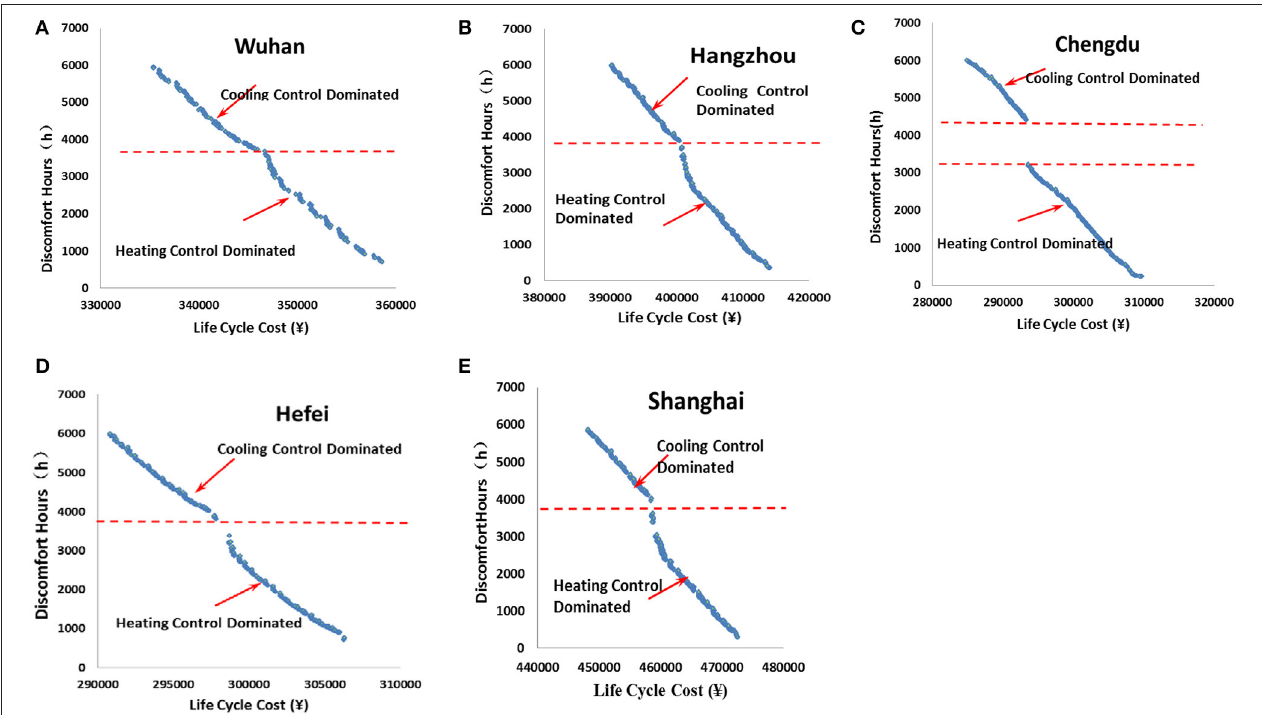
FIGURE 15 | (A) Pareto solutions for Wuhan. (B) Pareto solutions for Hangzhou. (C) Pareto solutions for Chengdu. (D) Pareto solutions for Hefei. (E) Pareto solutions for Shanghai.